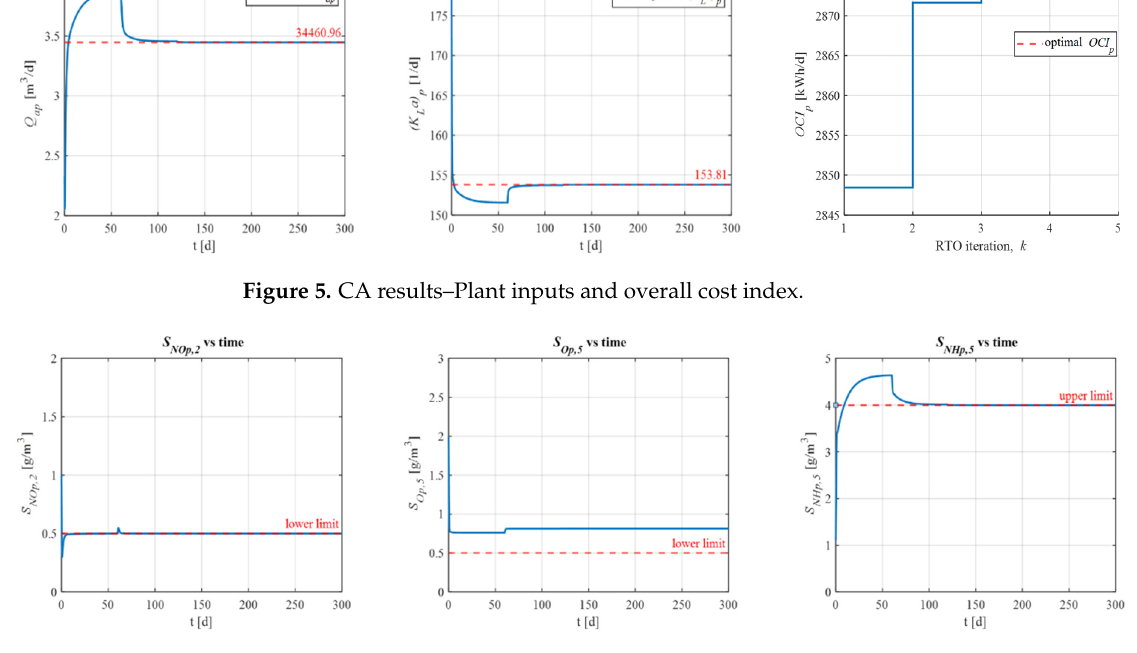
Figure 6. CA results–Plant variables.